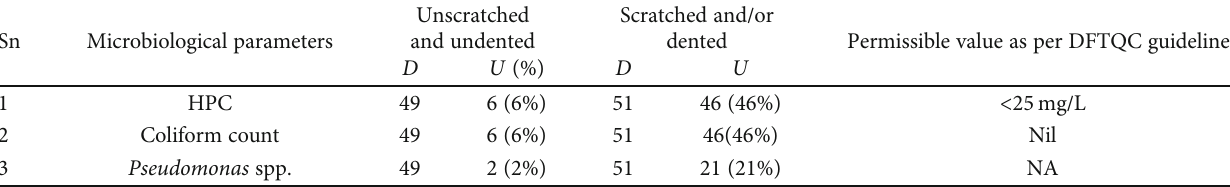
Pseudomonas spp.